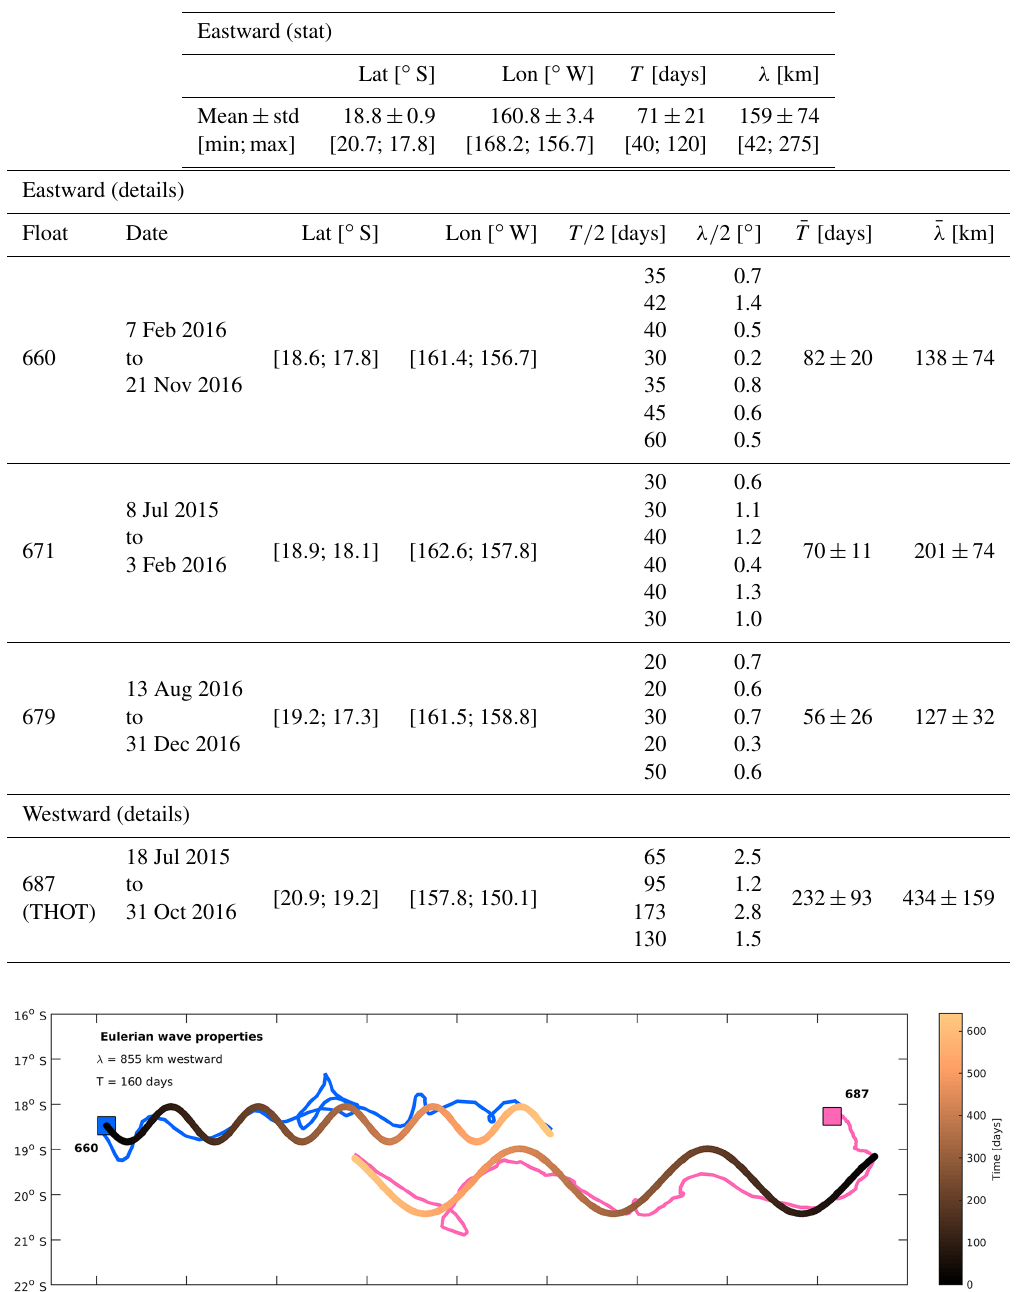
Table 3. Period T and wavelength λ of the float waves. The mean, standard deviation and extrema values are calculated for the eastward floats: 660, 671 and 679 (top of the table). Then details are given for each float: dates, geographical area, half periods, half wavelengths and corresponding mean and standard deviation values for T and λ .